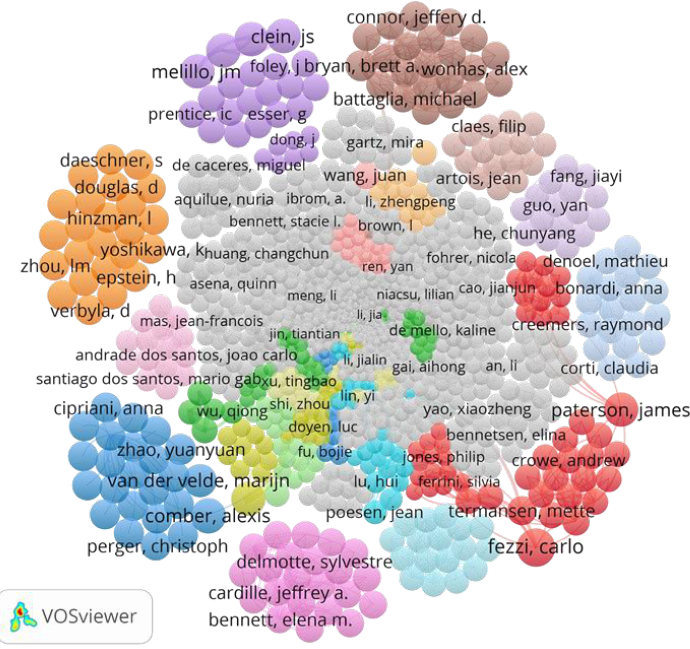
/ log modularity clustering (147